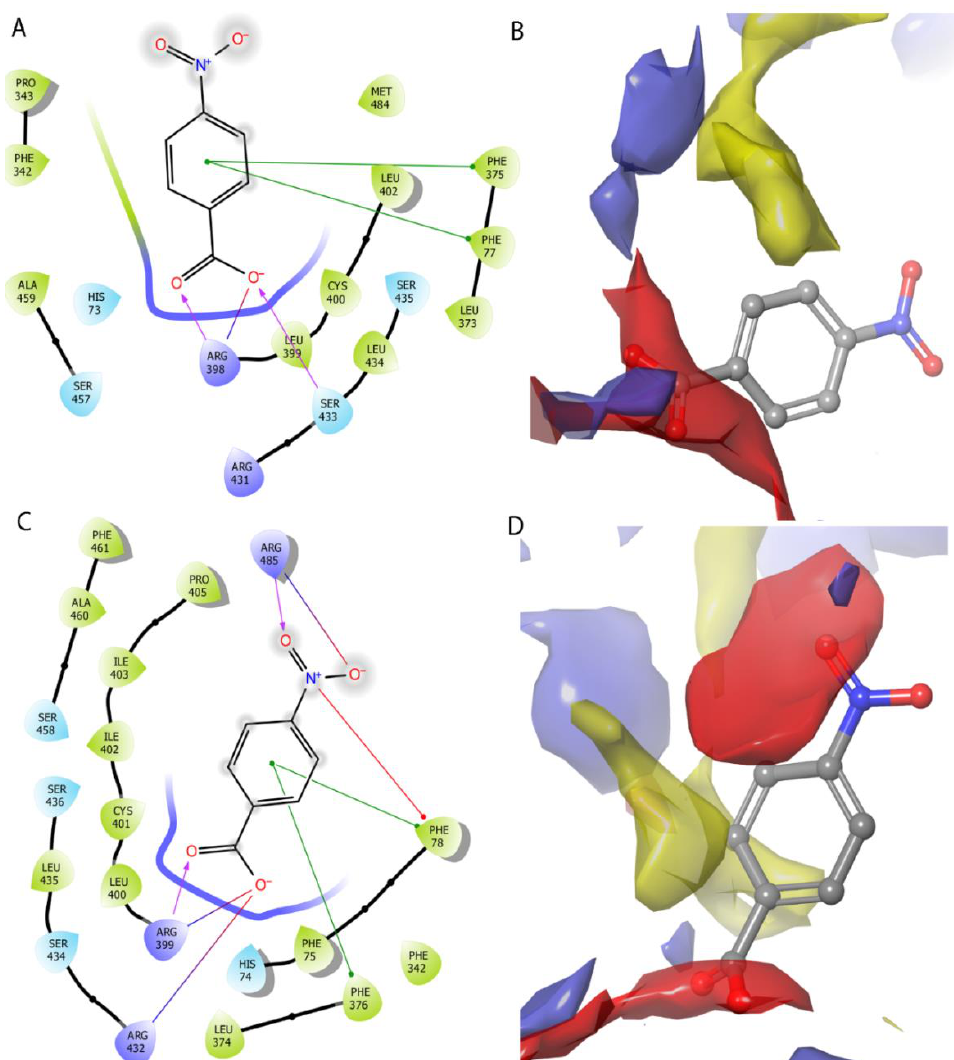
Figure 9. Binding model of HEA- p NBA in the auxin-binding site of CsTIR1 ( A , B ) and SlTIR1 ( C , D ). The blue surface is favorable for occupancy by functional groups that act as hydrogen bond donors, the red surface for hydrogen bond acceptor groups and the yellow areas can easily accommodate hydrophobic parts of a potential ligand.